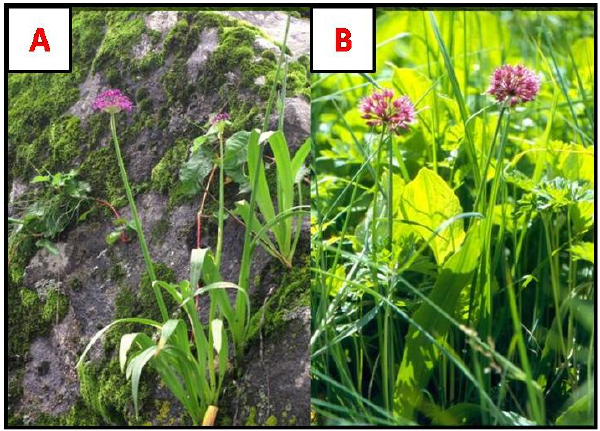
Fig. 1. Habitat of Allium wallichi (A) and Allium strachey